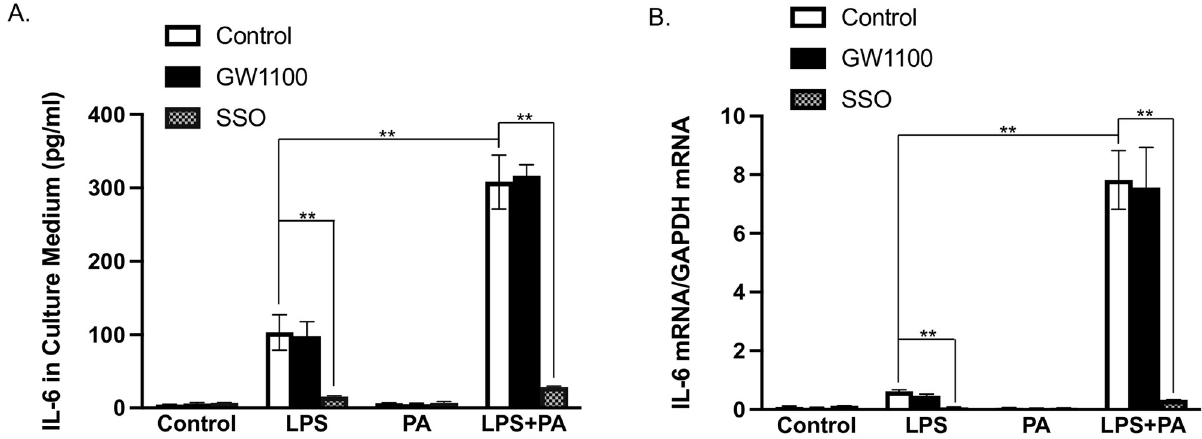
Fig 8. The effect of GPR40 antagonist GW1100 or CD36 inhibitor SSO on IL-6 secretion and expression in response to LPS, PA or both in macrophages. RAW264.7 macrophages were treated with 1 ng/ml LPS, 100 μ M of PA or both in the absence or presence of 5 μ M GW1100 or 50 μ M SSO for 24 h. After the treatment, the culture medium was collected for IL-6 ELISA (A) and total RNA was isolated from cells to quantify IL-6 mRNA using real-time PCR (B). The presented data (means ± SD) were representative of three experiments with similar results. Student’s t test was used for the statistical analysis. � p < 0.05; �� p < 0.01. SSO, sulfosuccinimidyl oleate; LPS, lipopolysaccharide; PA, palmitic